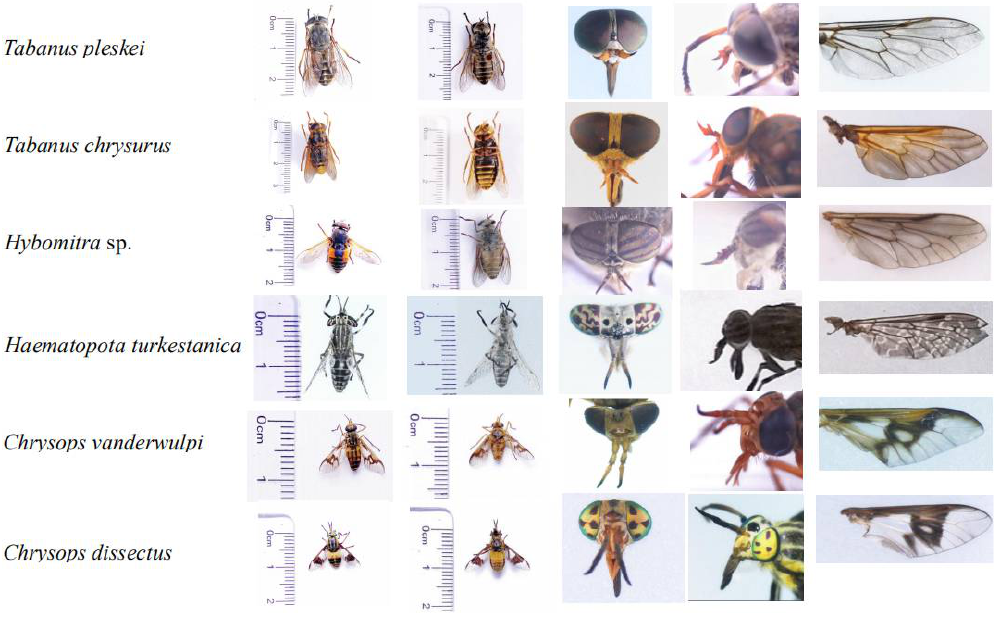
Figure 1. Morphological pictures of horseflies in this study, they are dorsal view of abdomen; abdomen; head; antennae; and wing.